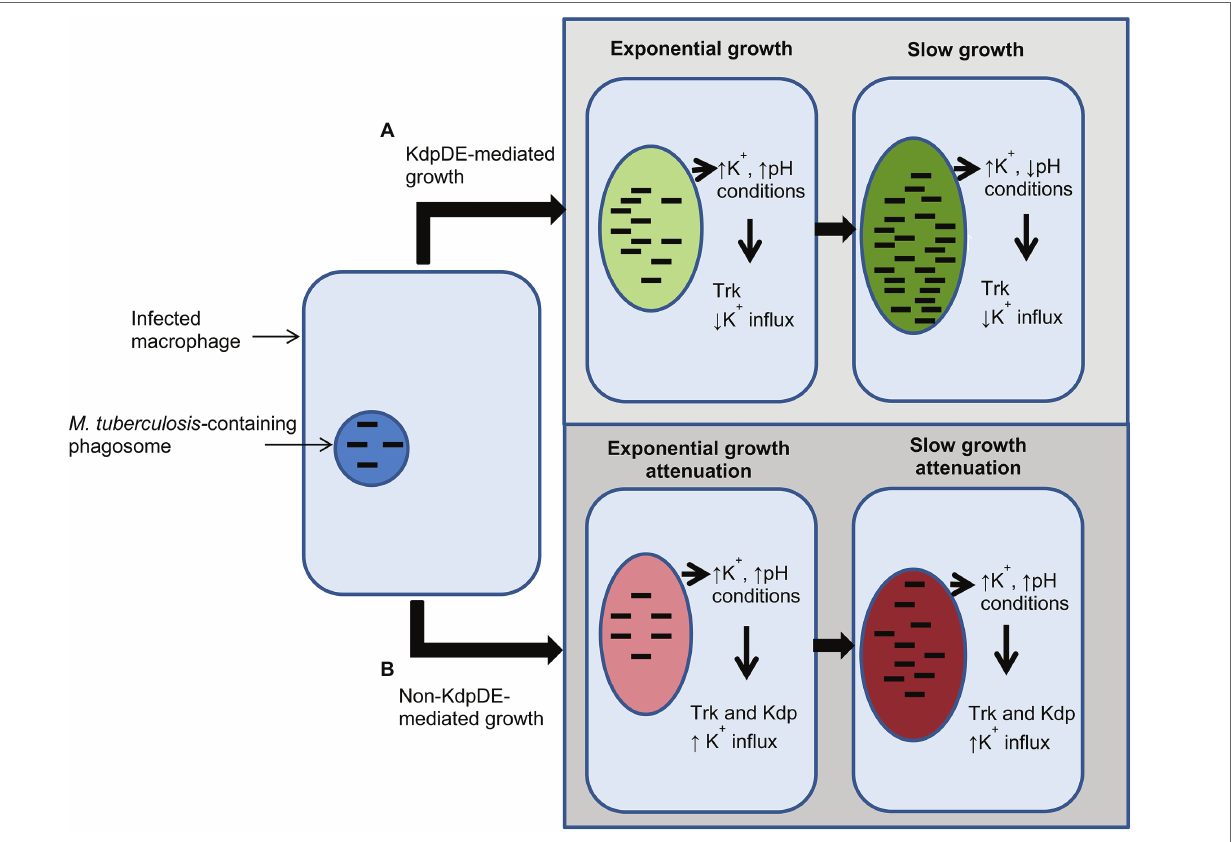
FIGURE 6 | Schematic illustration summarizing events involved in bacterial growth in macrophages in the presence and absence of the two-component system (TCS) KdpDE. (A) In the presence of the KdpDE system, bacteria utilize the Trk transporter for K + uptake suppressing the KdpFABC transporter, while (B) in the absence of the KdpDE both the KdpFABC and the Trk systems are constitutively activated, resulting in excessive influx of K + , which is detrimental to the bacteria, leading to attenuation of bacterial growth. ↑ K + , phagosomal potassium concentration (19–50 mM); ↑ pH, pH 6.7–6.8; ↓ pH, pH